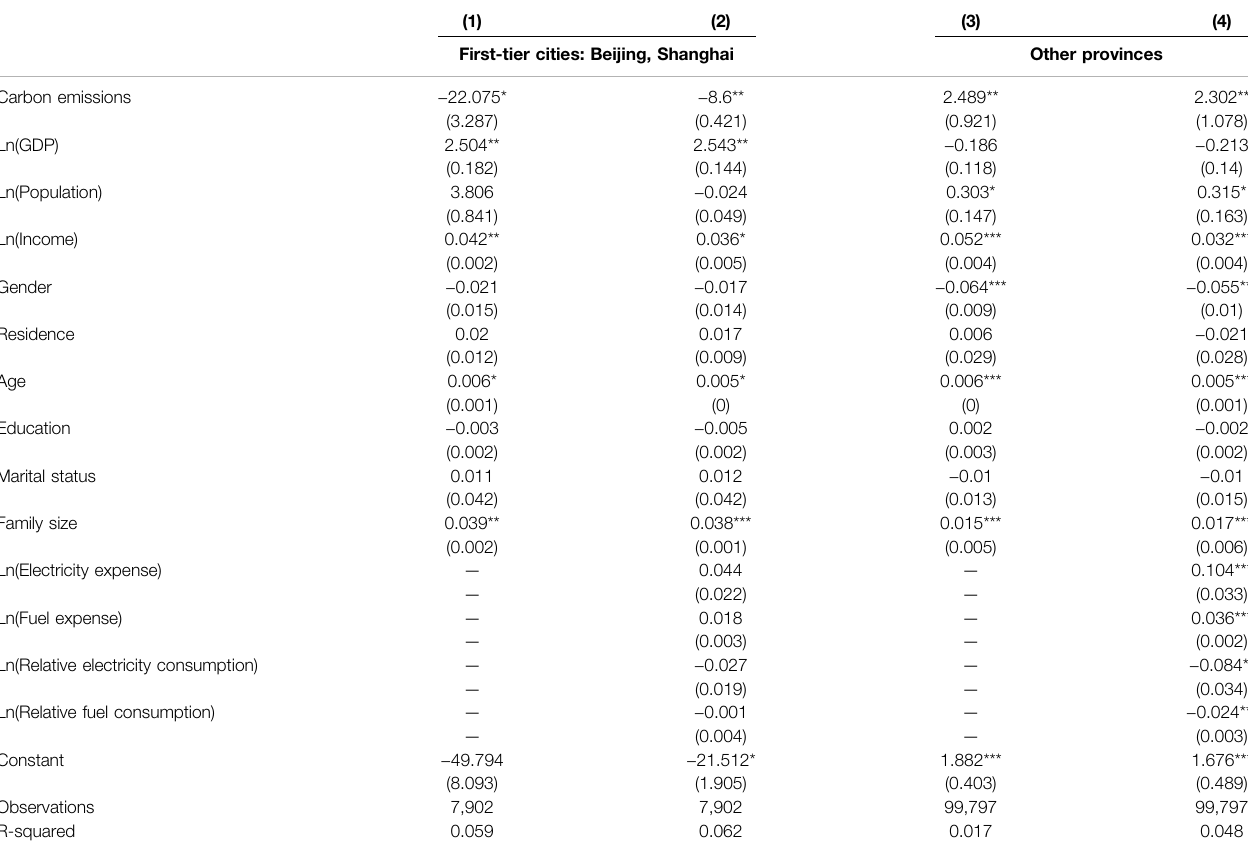
TABLE 4 | Impact of carbon emissions, energy consumption on Life satisfaction in Beijing and